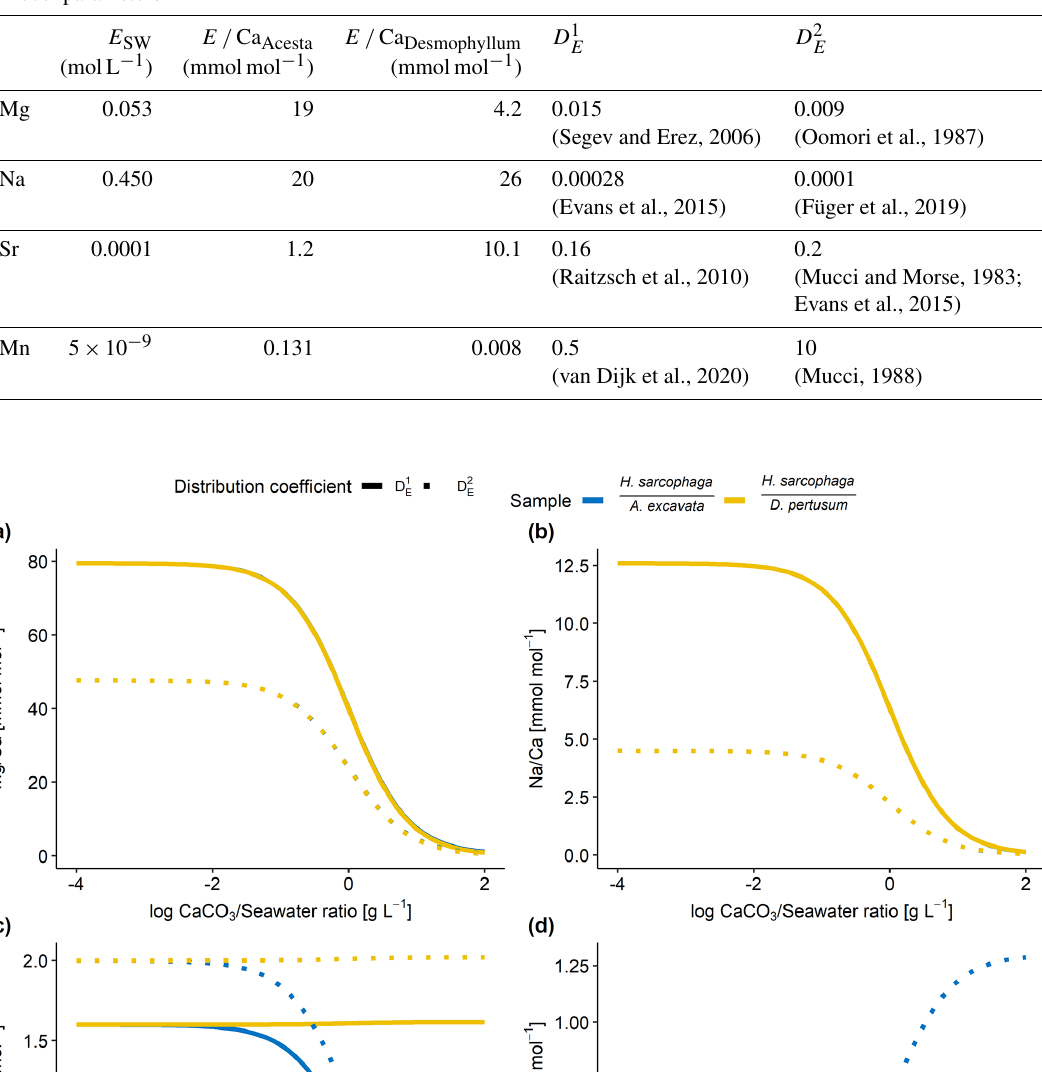
Table 4. Parameters used in the proposed model to explore the effects of carbonate and water uptake of H. sarcophaga on the shell chemistry. Host element / Ca ratios are derived from this study. D 1